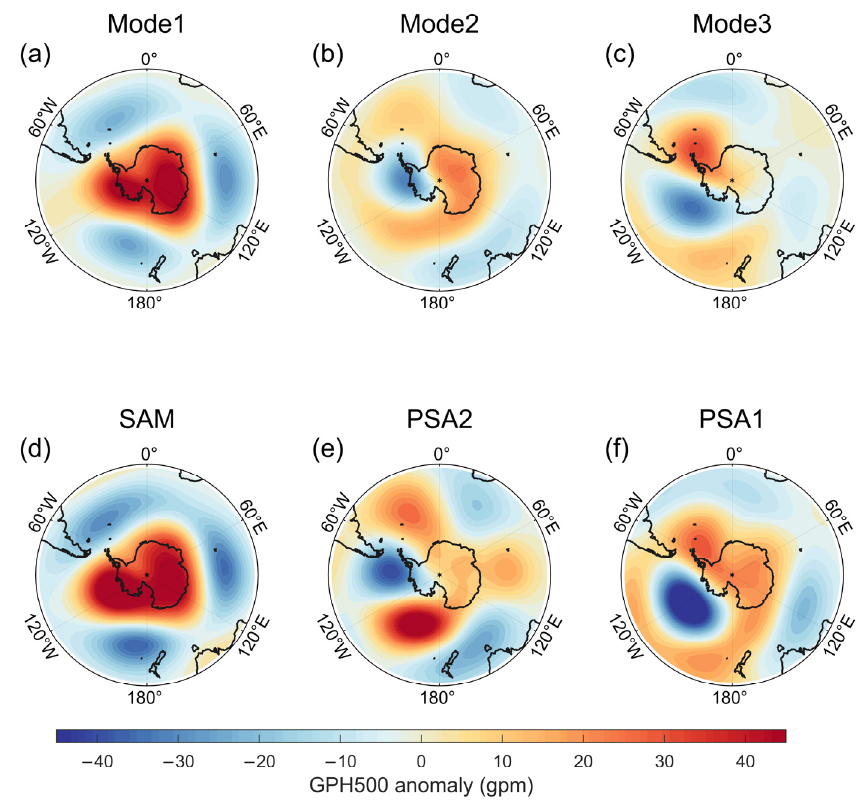
Figure 3. The 500 hPa geopotential height (GPH500) projection of the first three modes ( a – c ) of the combined maximum covariance analysis (CMCA) and the first three principle GPH500 modes over the southern hemisphere ( d – f ).